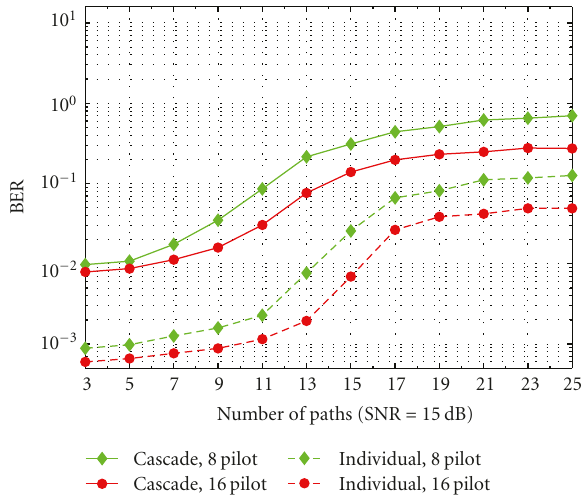
Figure 5: BER performance change by the number of channel paths for 8 and 16 pilots, and 15 dB